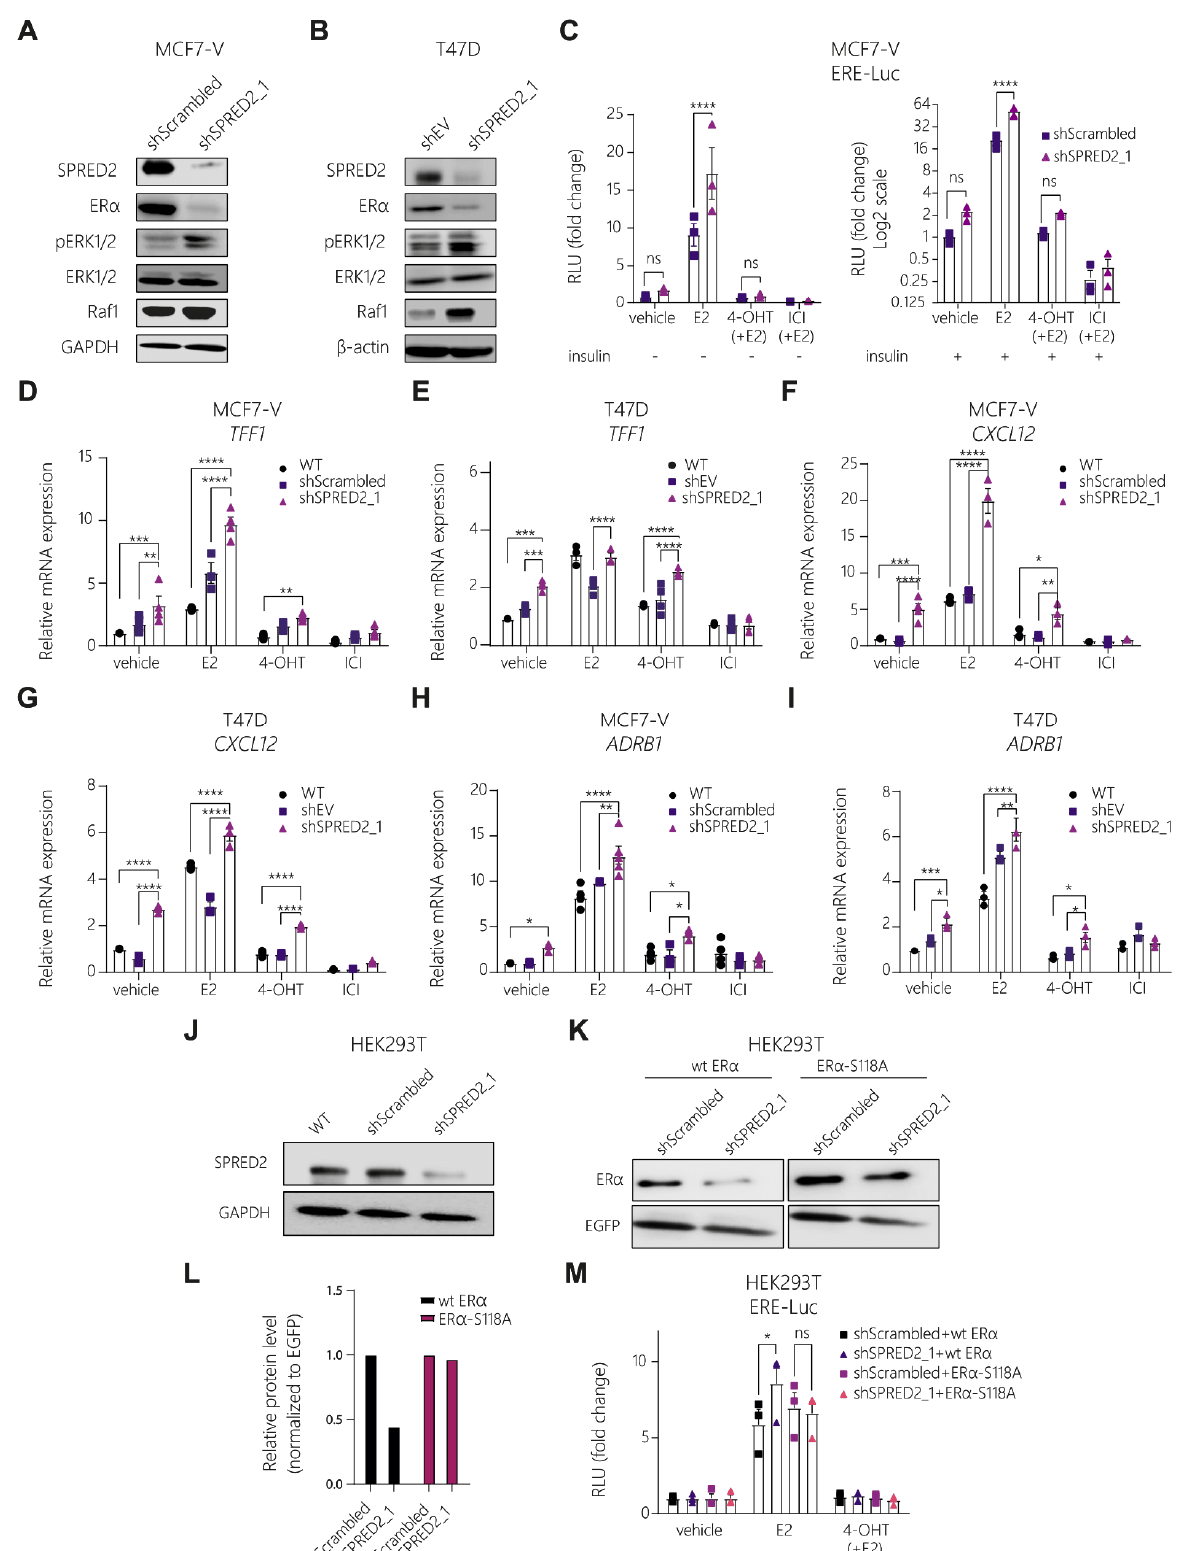
Figure 3. Knockdown of SPRED2 stimulates ER α transcriptional activity by increasing the activity of the MAPKs ERK1/2. ( A , B ) Immunoblots for the indicated proteins of MCF7-V ( A ) and T47D ( B ) SPRED2 knockdown and control cells. ( C ) Luciferase reporter assays for endogenous ER α